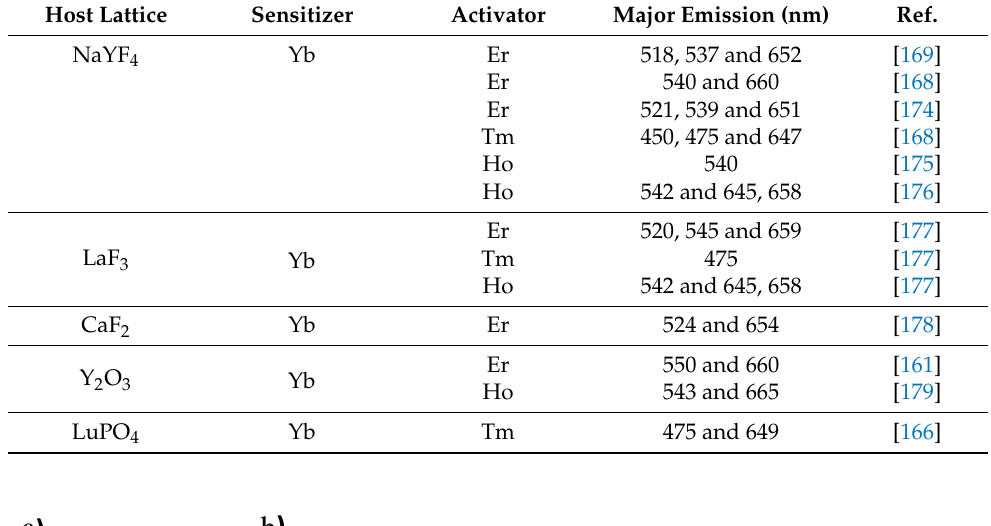
Table 6. Optical characteristics of representative UCNPs